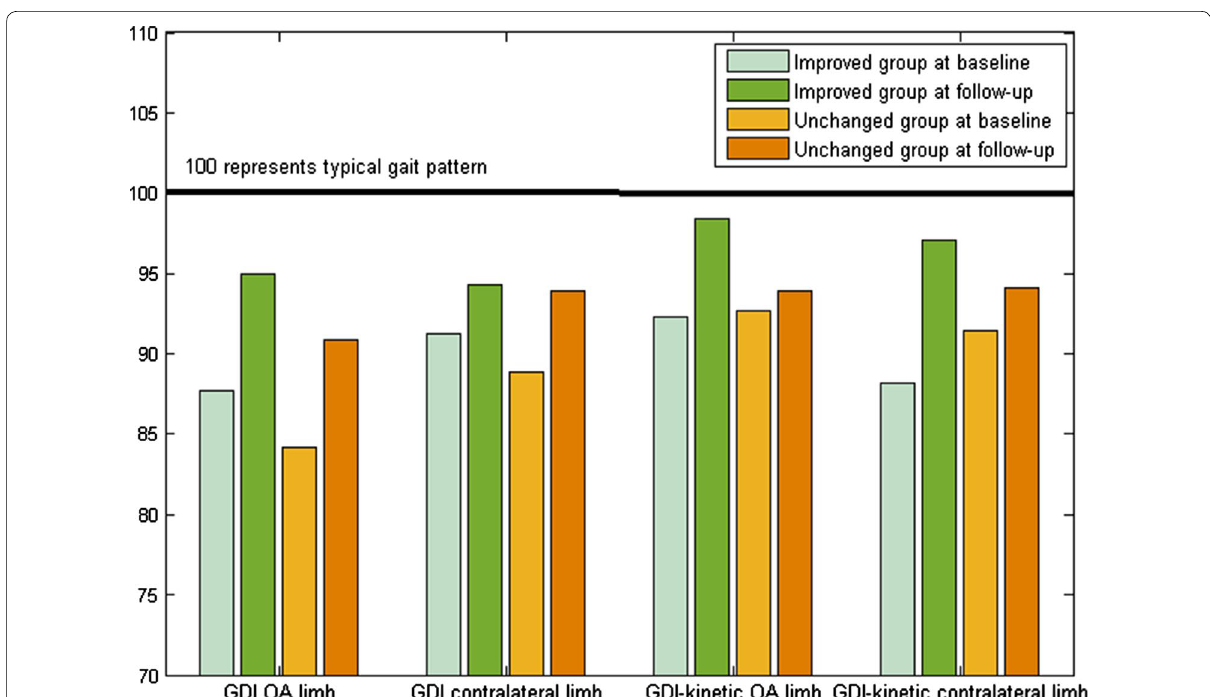
Fig. 2 Overall gait pattern, evaluated using the Gait Deviation Index for kinematics (GDI) and kinetics (GDI-kinetic), at baseline and at 1 year after total hip arthroplasty in ( n 34) patients with hip osteoarthritis. Patients grouped by postoperative change in performance-based function =